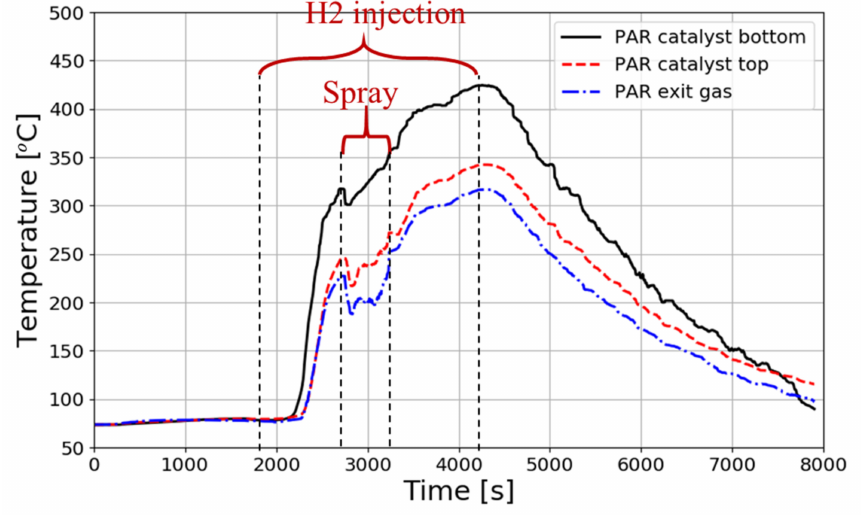
Figure 26. Variations in the catalyst and exhaust gas temperatures during the SSP4 test.